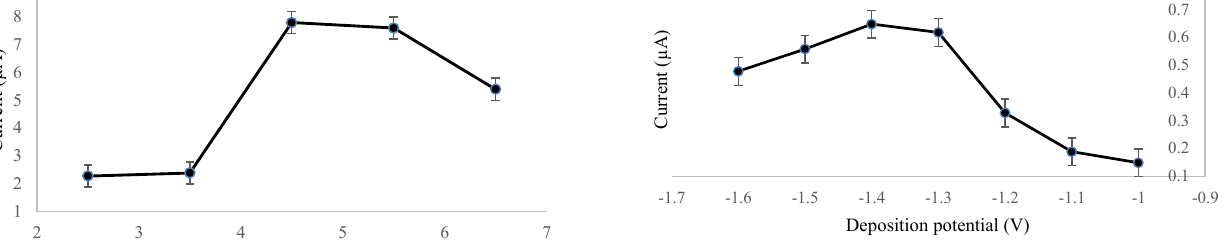
Figure 2. Effect of different deposition potentials applied to a 1.0ppm standard cadmium solution in an acetate buffer with pH 4.5.